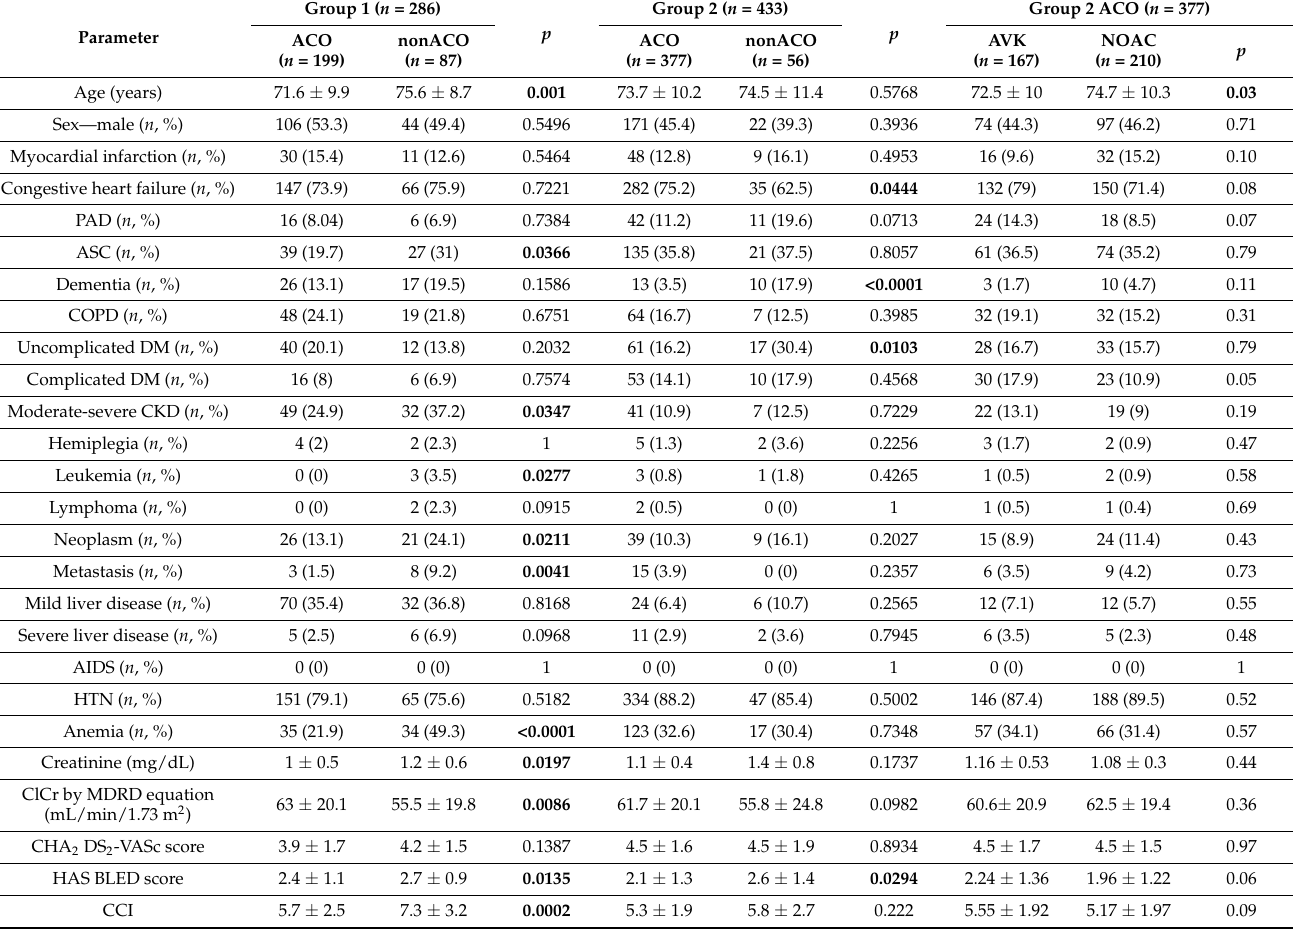
Table 3. Comparison between demographic and clinical data in nonvalvular atrial fibrillation patients on oral anticoagulation and non-anticoagulated in both groups and respectively between those anticoagulated with AVK or NOAC in group